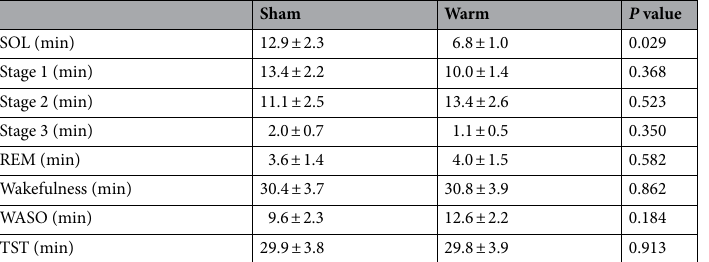
Table 2. EEG sleep parameters during the whole sleep period. All values are expressed as mean ± SEM of eighteen subjects. Comparisons were performed relative to the sham condition using the Wilcoxon signed rank test. SOL, sleep onset latency; REM, rapid eye movement; WASO, wake after sleep onset; TST, total sleep time.